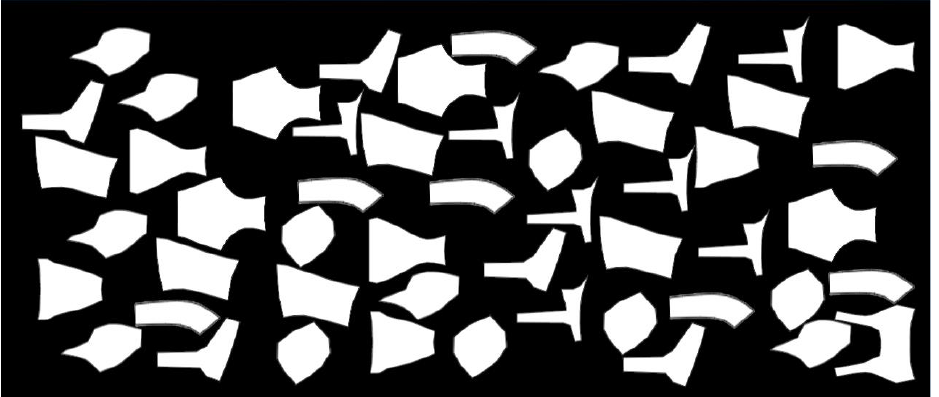
Figure 16. Solution found by the ILS algorithm inserting 51 pieces for the Swim instance, consum- ing 2 h of processing time.